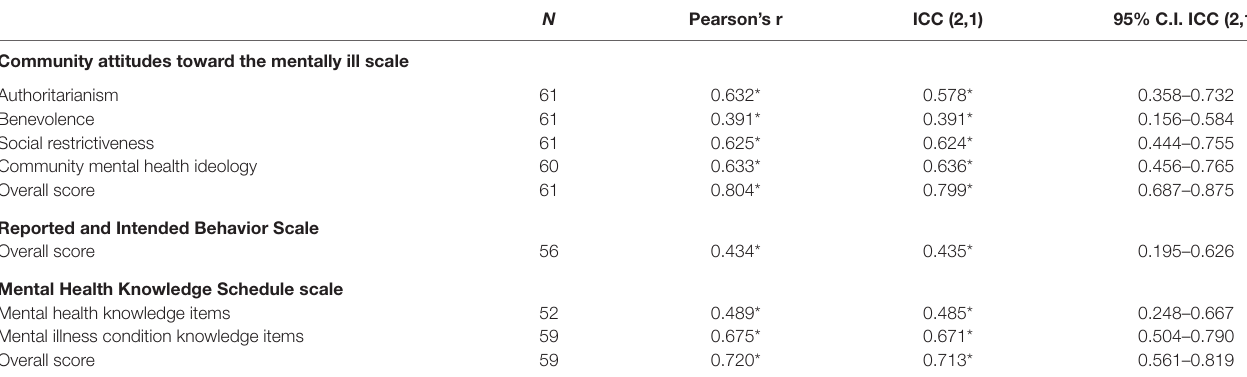
TaBle 3 | Long-term stability of the three stigma scales.